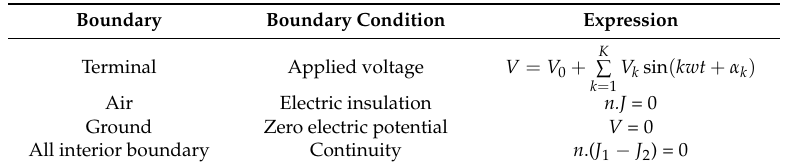
Table 4. Boundary settings of the model.